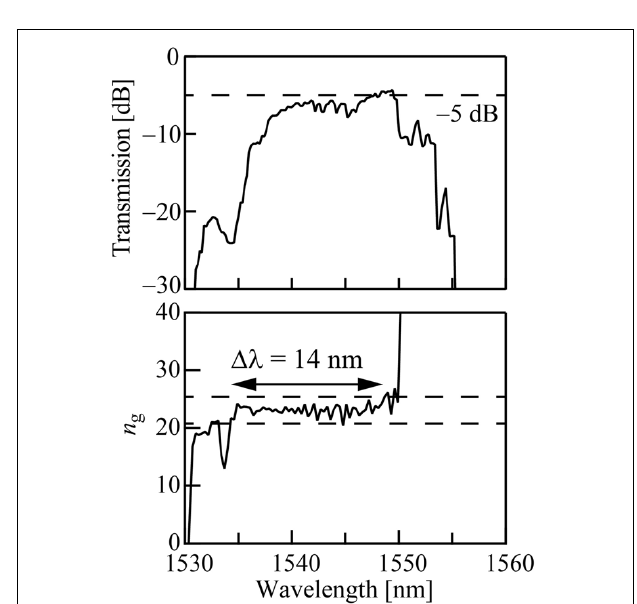
FIGURE 8 | Measured spectra of transmission intensity and group index. The broken line shows the wavelength which was used in the modulation